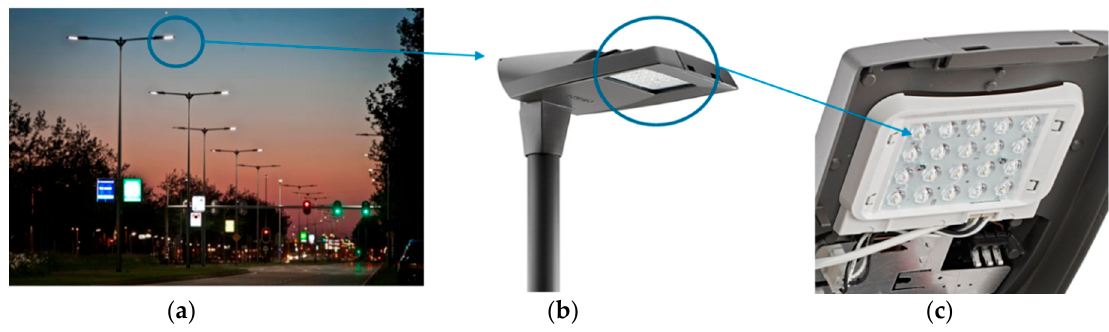
Figure 1. Outdoor applications: street lighting ( a ); outdoor luminaire ( b ); and lens optics ( c ).